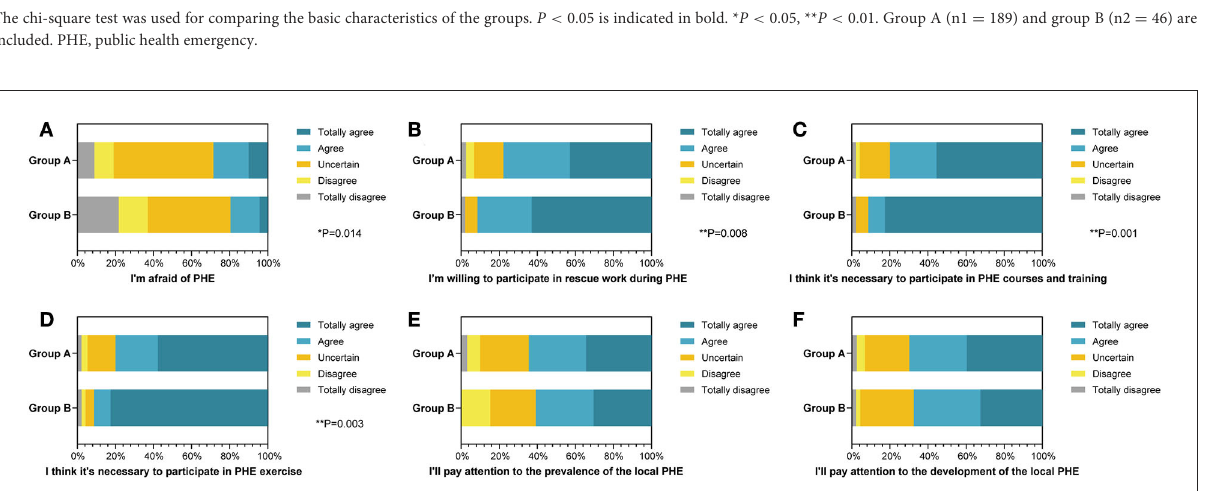
they had mastered sufficient skills to cope with